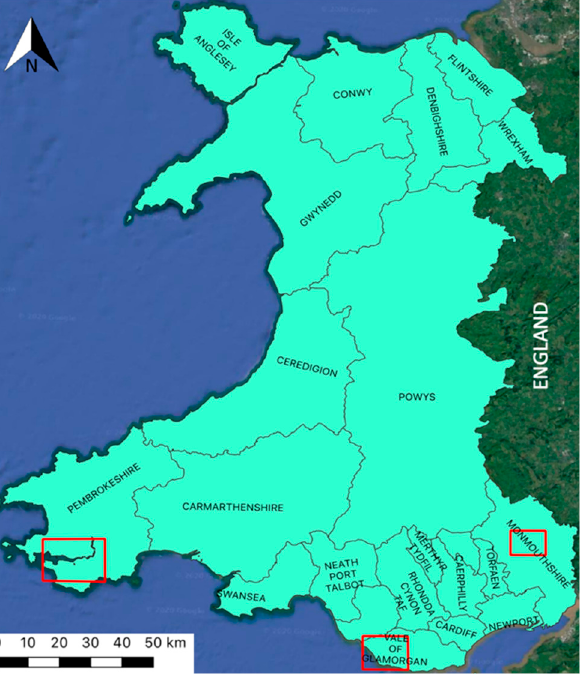
Figure 1. Regions of Wales. The red rectangles represent the three areas used for the validation step. Pembrokeshire is characterized by very complex and diverse landscapes. The north is rural with many small settlements [49]. The slopes and valleys are covered with small broadleaved woodlands and mixed or coniferous plantations but many of the flatter areas consist of a mix of fields with pasture, cereals, or hay meadows. In the south, the diverse agricultural land uses include cereal cropping, dairying, sheep rearing, and rough graz- ing [50]. The Pembrokeshire landscape is a mosaic of fields of varying size bounded by hedgerows, hedgerow trees, and hedgebanks. The average size of agricultural fields is 3.76 ha (4.62 ha when excluding grasslands, i.e., crops only). The agricultural area not covered by grasslands consists about equally of horticulture, winter cereals, and spring cereals [source: 2018 Land Parcel Identification System (LPIS)]. The Vale of Glamorgan is a distinctive, gentle lowland landscape, largely comprising a rolling limestone plateau with a patchwork of fields and woodlands [51]. The field sizes are larger than in Pem- brokeshire, with an area average of 5.44 ha but 7.64 ha for croplands [source: 2018 LPIS]. Monmouthshire is also predominantly low lying with the landscape comprised of undulat- ing hills, valleys, and floodplains. Sheep grazing and dairy farming are commonplace and arable farming is largely confined to the fertile floodplains. As farming is intensive, the extent of semi-natural or ecologically rich habitats is quite limited with the exception of the woodlands [52]. The average sizes of all fields and those used only for crops are 3.85 and 5.46 ha,